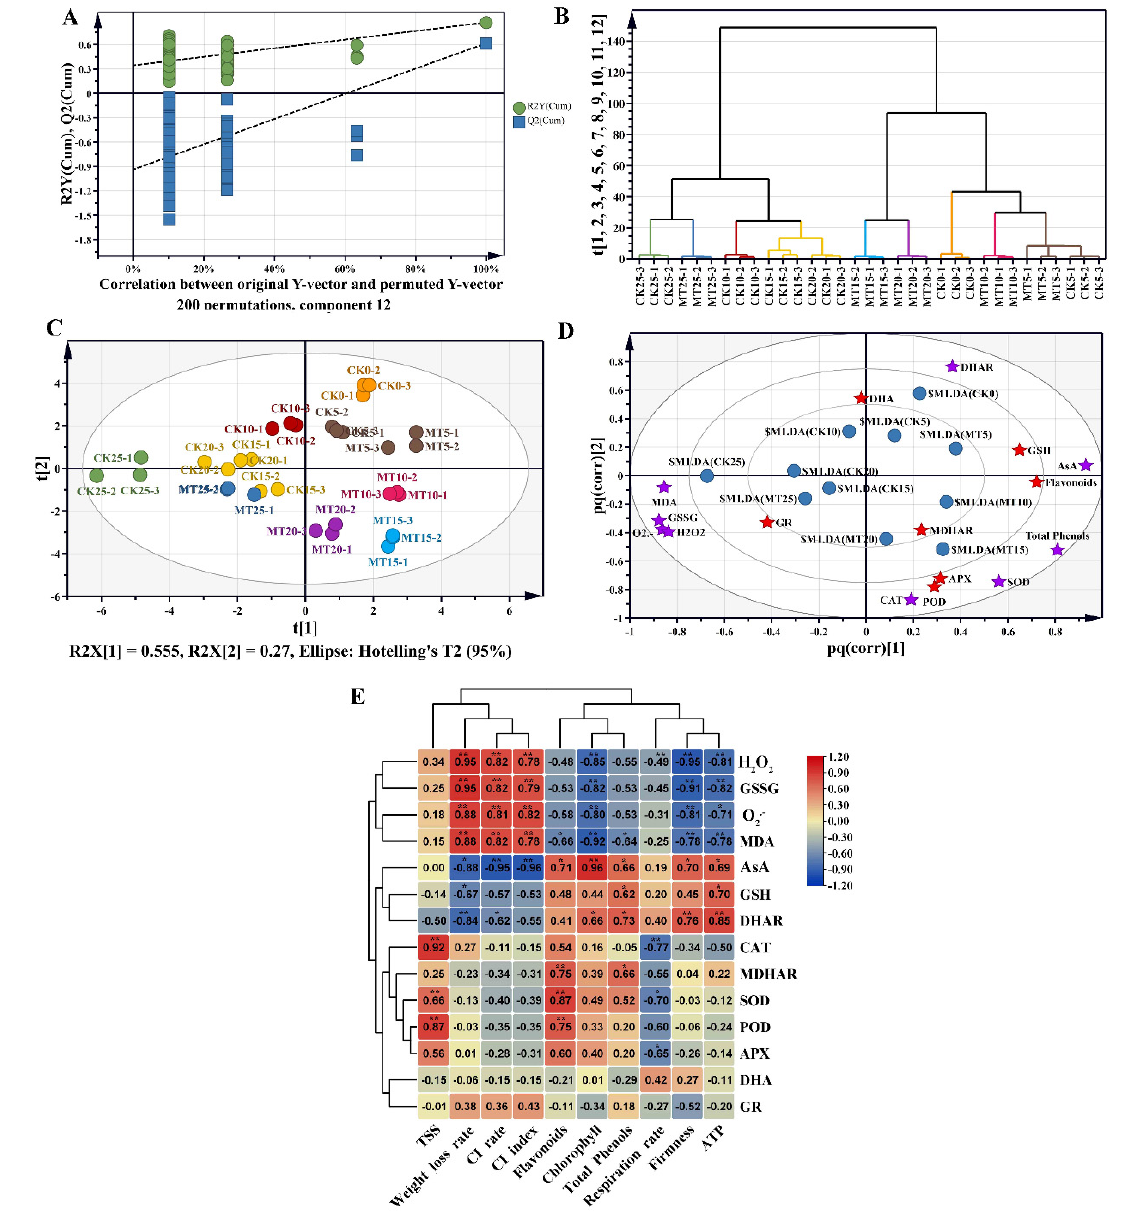
Figure 6. Correlation analysis of ROS metabolism with pepper CI and fruit quality. ( A ) permutations plot of PLS-DA, ( B ) hierarchical clustering analysis plot of PLS-DA, ( C ) score scatter plot of PLS-DA, ( D ) loading scatter plot of PLS-DA, ( E ) correlation analysis of ROS metabolism related indicators with pepper CI and fruit quality. The blue dots in ( D ) represents different samples, and the asterisks represent different ROS metabolism-related indicators, red being for VIP > 1 and purple for VIP < 1.